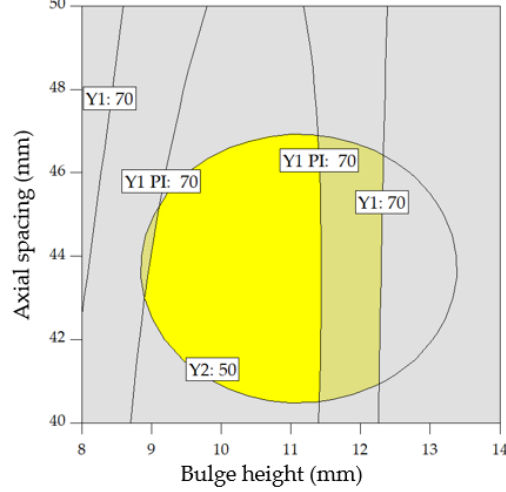
Figure 11. Optimum analysis of